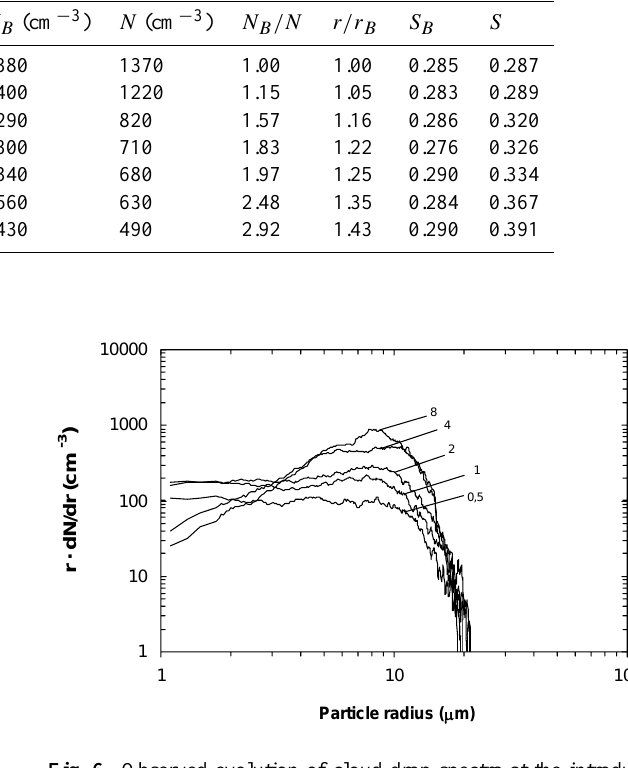
Figure 6. Observed evolution of cloud drop spectra at the introduction of salt powder into the 3 Fig. 6. Observed evolution of cloud drop spectra at the introduc- BCC with the mass concentration of 9.7 mg/m 3 (numbers at the curves – time (min.) after the 4 tion of salt powder into the BCC with the mass concentration of beginning of cloud medium formation. 5 9.7mg/m 3 (numbers at the curves – time (min) after the beginning of cloud medium formation.